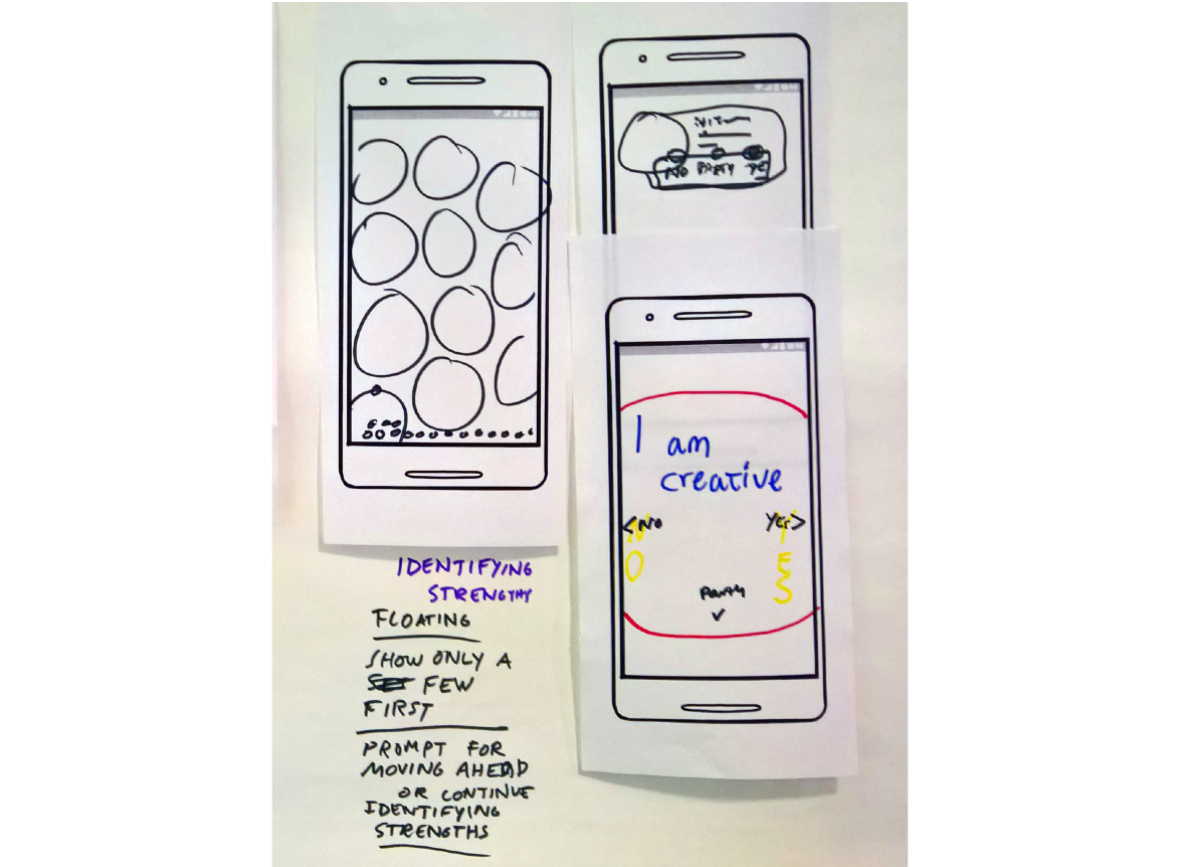
Figure 6. Home Screen Sketch